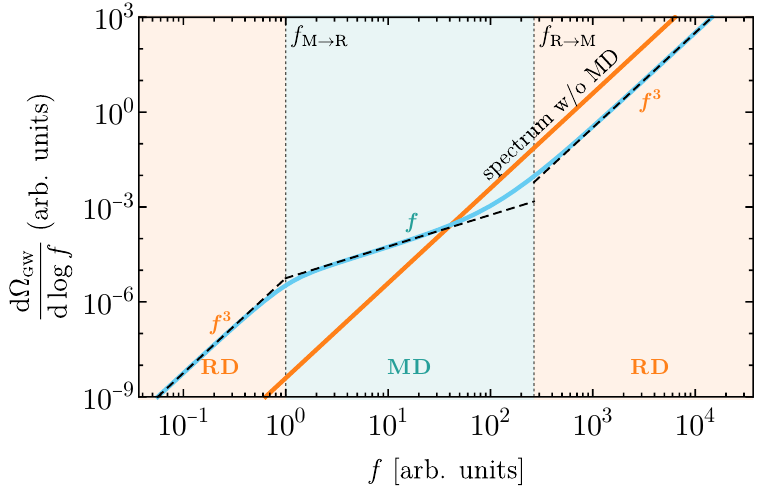
Figure 3 . The low-frequency spectrum of causality-limited GWs in the case with an intermediate period of matter domination (light blue) and the case with just radiation domination (orange). The intermediate period of matter domination is present between the frequencies f m → r to f r → m . The dashed black lines show the scaling as f ( f 3 ) during MD (RD). High frequency modes have less power due to the presence of MD while low frequency modes have more